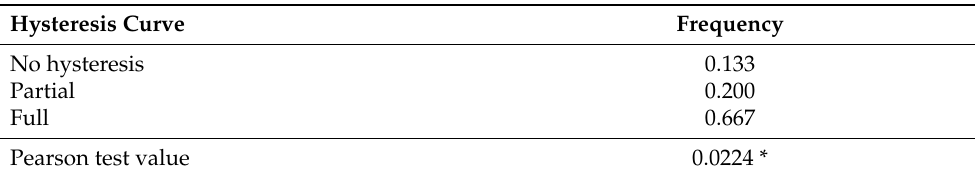
Table 4. Frequency of the observations showing hysteresis curves in fruits 2, 3 and 4 in the second period of study. Asterisk indicates that Pearson test was significant ( p -value <